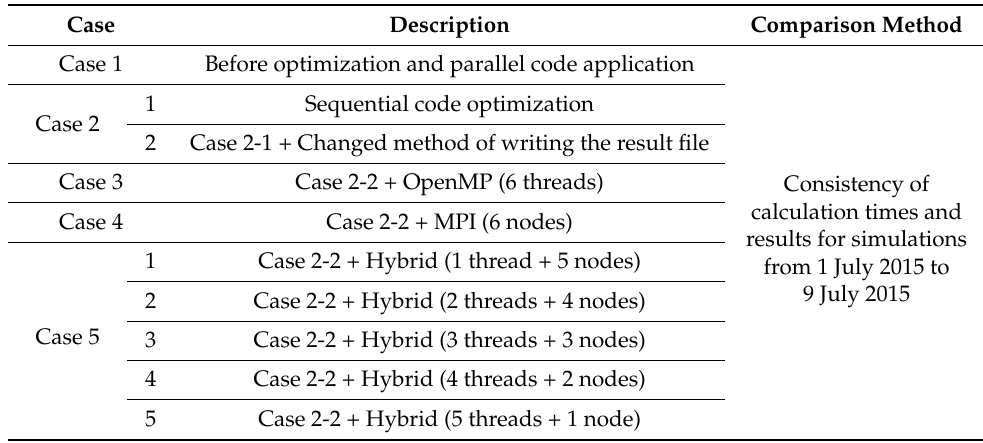
Table 2. Method for evaluating the parallelization performance.